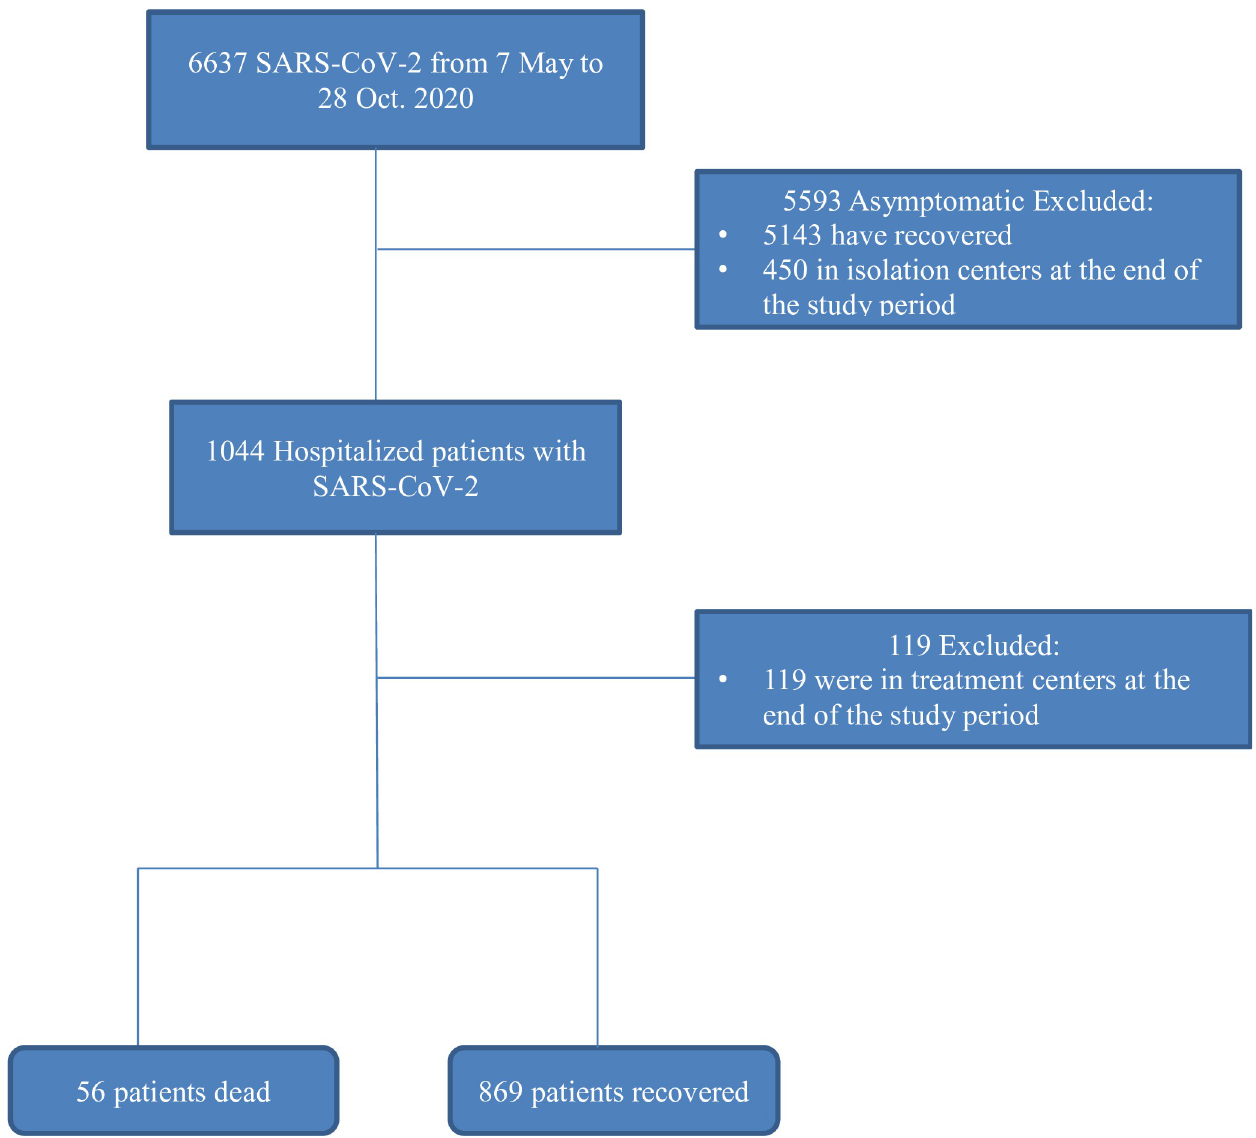
Fig 1. Flowchart of the study design and participants. Only the rounded rectangles were included in the analysis. patients who had a definite outcome (dead or recovered) were included (Fig 1). The median age of the patients was 30 years (IQR, 25–44) and 70.1% (95% CI: 67.1%-73.0%) were male patients. The patients in the non-survivor group were much older than those in the survivor group [median = 57.5 years (IQR, 29.5–72 years) versus median = 30 years (IQR, 24–42 years), p -value < 0.001]. A total of 45.6% (95% CI: 42.4% - 48.8%) patients were younger than 30 years, 35.2% (95% CI: 32.2% - 38.3%) were aged between 30 and 49 years, 13.6% (95% CI: 11.4% - 15.8%) were between 50 and 69 years and 5.5% (95% CI: 4.0% - 7.0%) were older than (Table 1).